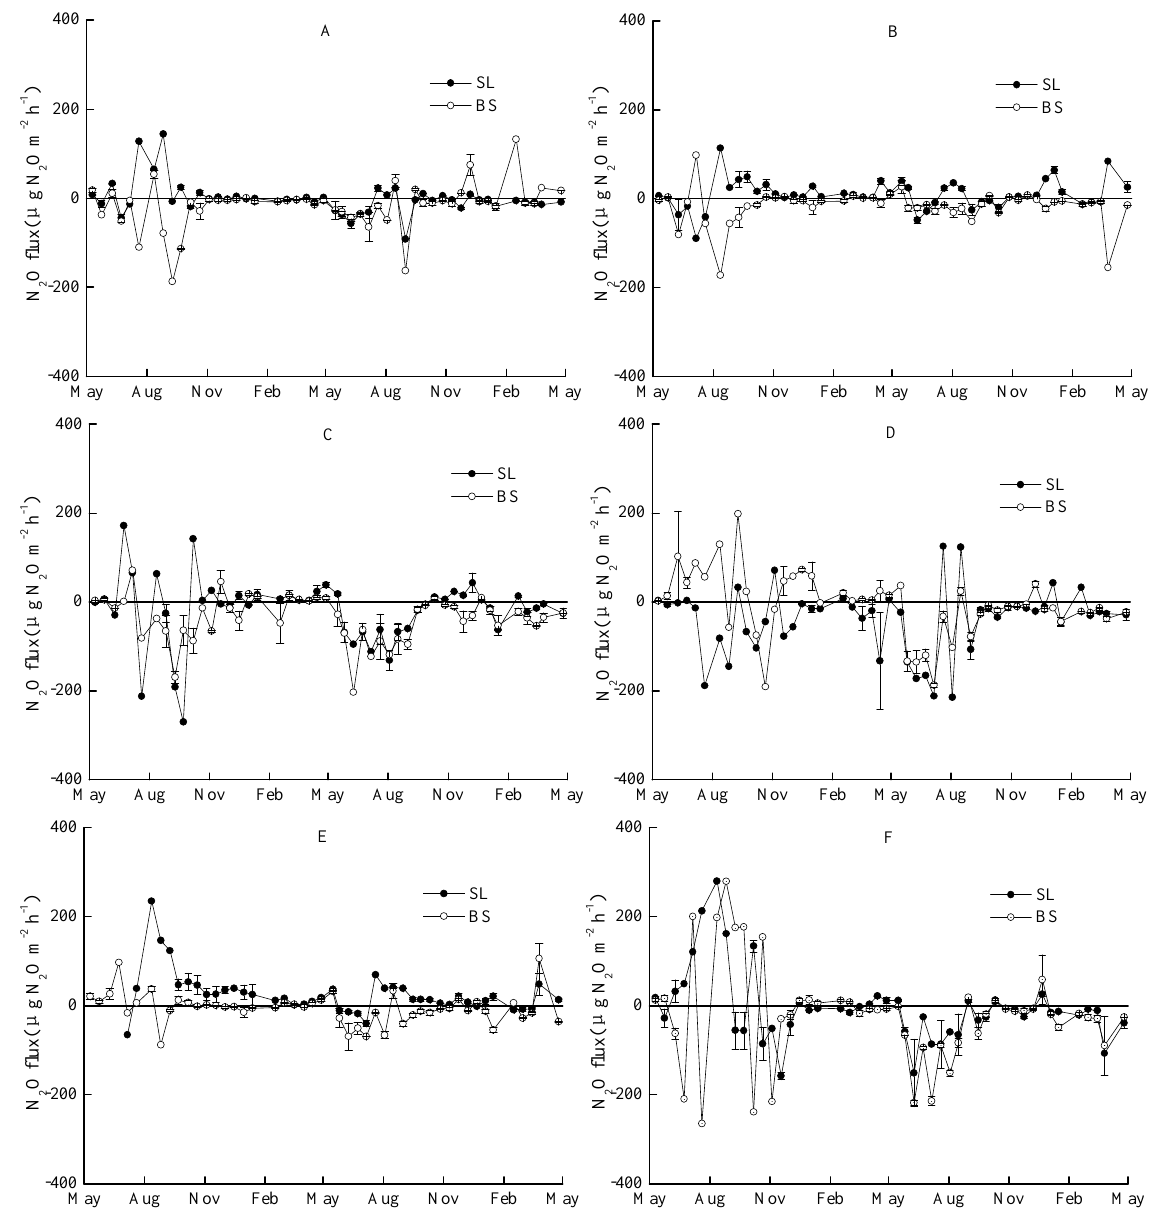
Fig. 5 Fig. 5. Seasonal patterns of N 2 O flux rates measured in six tree species on Taihang Mountain with (SL) or without (BS) surface litter from May 2010 to April 2012. The tree species are (A) Robinia pseudoacacia , (B) Vitex negundo var. heterophylla , (C) Leptodermis oblonga ,